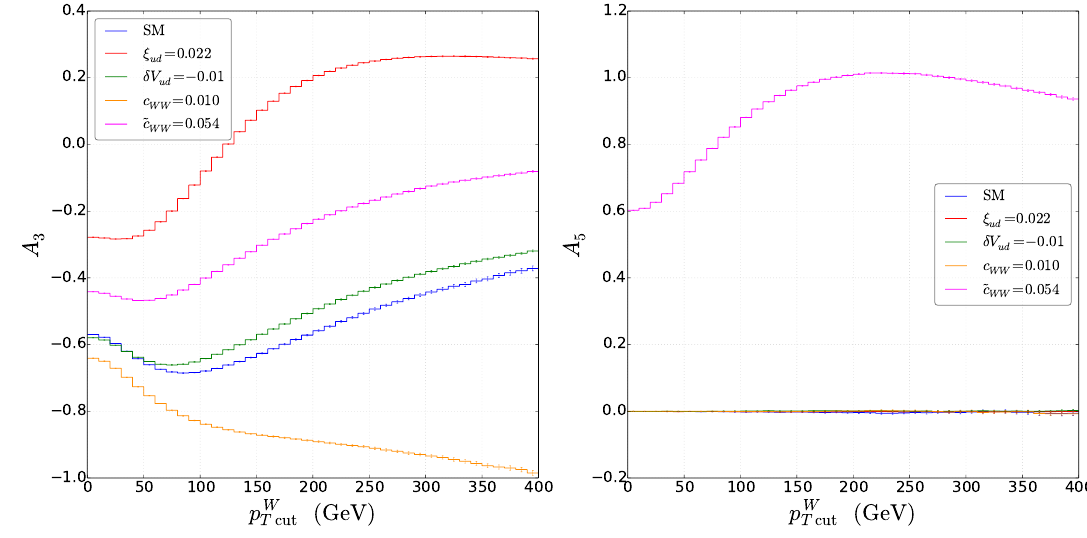
p , at S = 14 TeV. T cut = 120 GeV. For larger cuts, (cid:24) ud T cut 3